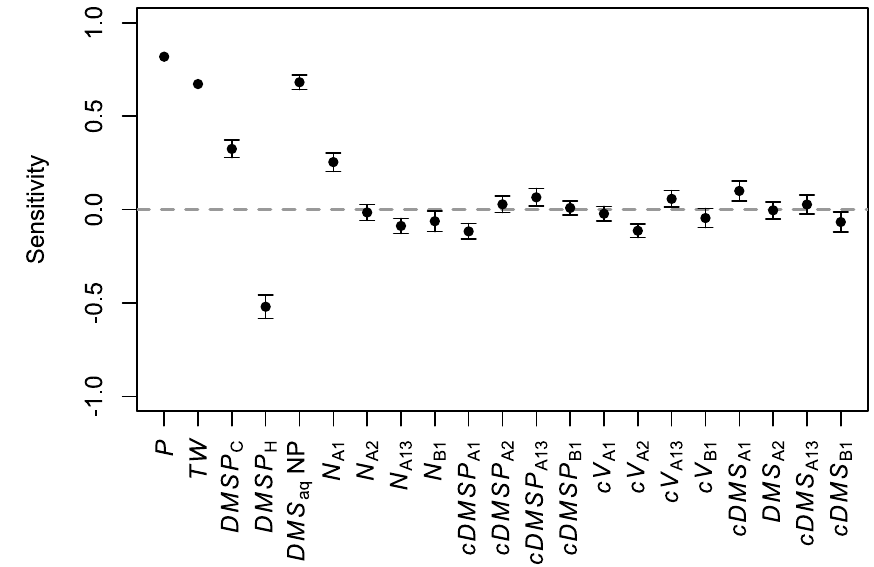
Figure 3. Sensitivity of the variables fed into the simulation framework. Values close to 0 have less influence on the simulation than those departing from 0. Error bars show standard error. Where error bars are not shown, they are smaller than the symbol size. DMS aq and DMS g , aqueous and gaseous dimethyl sulfide; P , percentage of DMS aq escaping into the atmosphere; TW, coral tissue weight normalised by coral surface area; DMSP C , dimethylsulfoniopropionate within corals; DMSP H , dimethylsulfoniopropionate in holobionts; DMS aq NP, net aqueous DMS production; N , number of cells for Symbiodinium clades A1, A2, A13 and B1; cDMSP, cellular DMSP for Symbiodinium clades A1, A2, A13 and B1; cV; cell volume for Symbiodinium clades A1, A2, A13 and B1; cDMS, cellular DMS g production rate for Symbiodinium clades A1, A2, A13 and